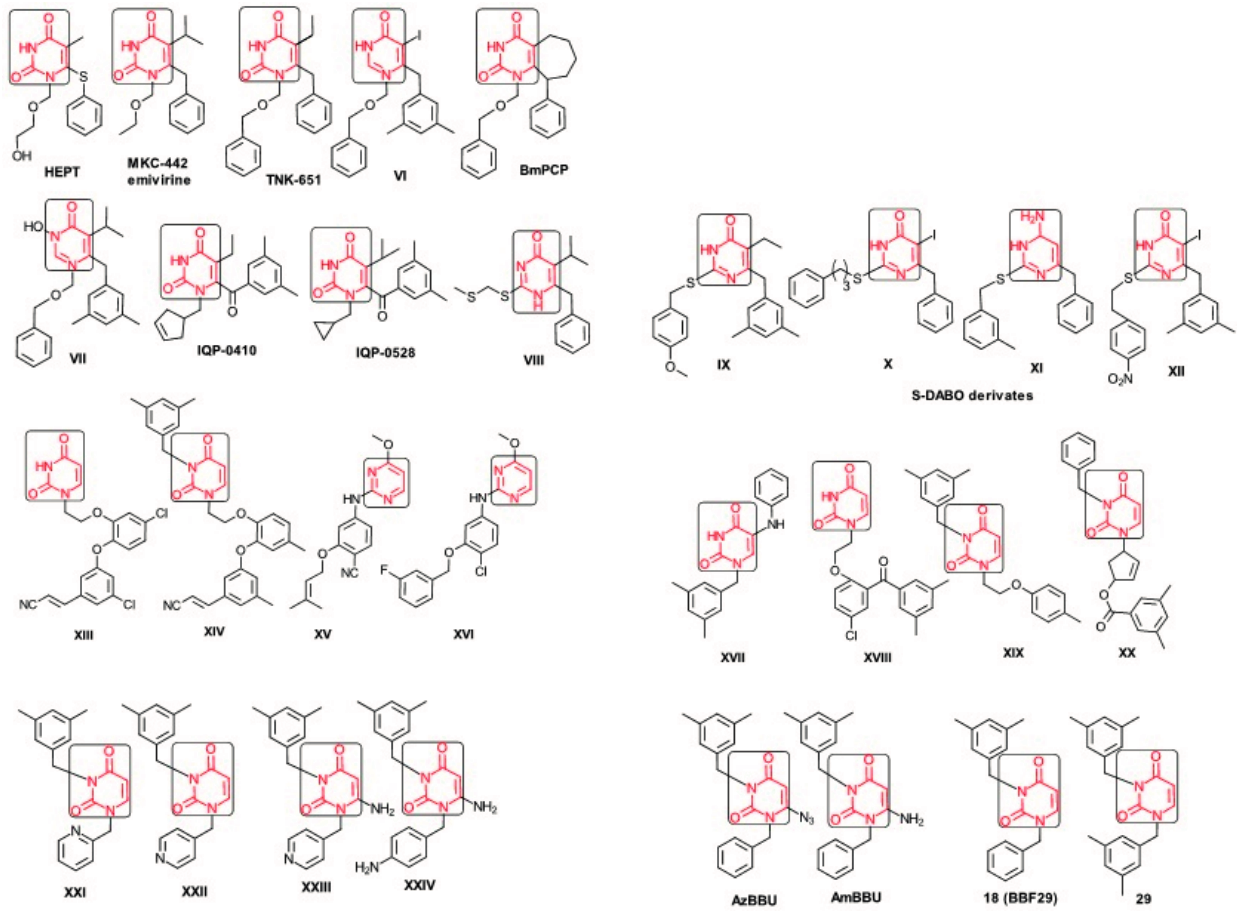
Figure 3. Pyrimidine derivatives already tested as NNRTI; the emphasized molecular fragments—also represented in the color red—are studied in this work. See text for